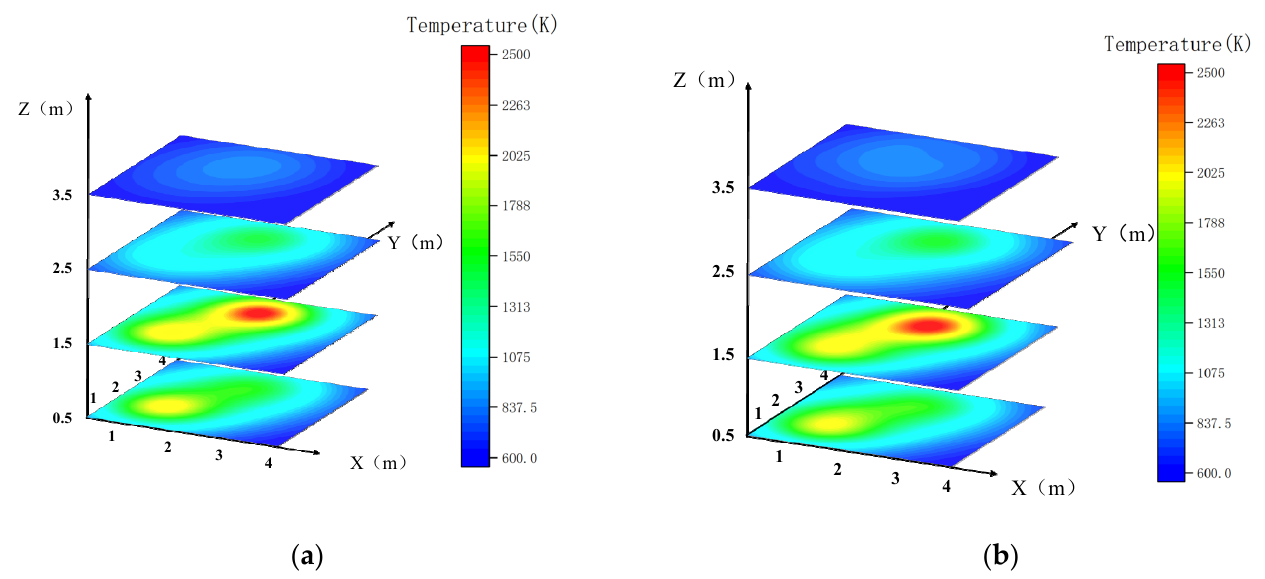
Figure 4. Bimodal temperature distribution model in the computational domain: ( a ) calculation results; ( b ) reconstruction results.